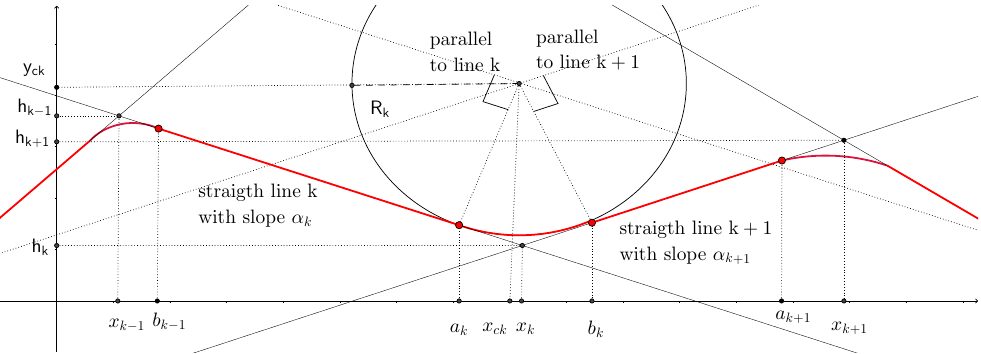
Figure 1. Longitudinal profile (in red) modeled as a sequence of straight lines connected by circular arcs (adapted from